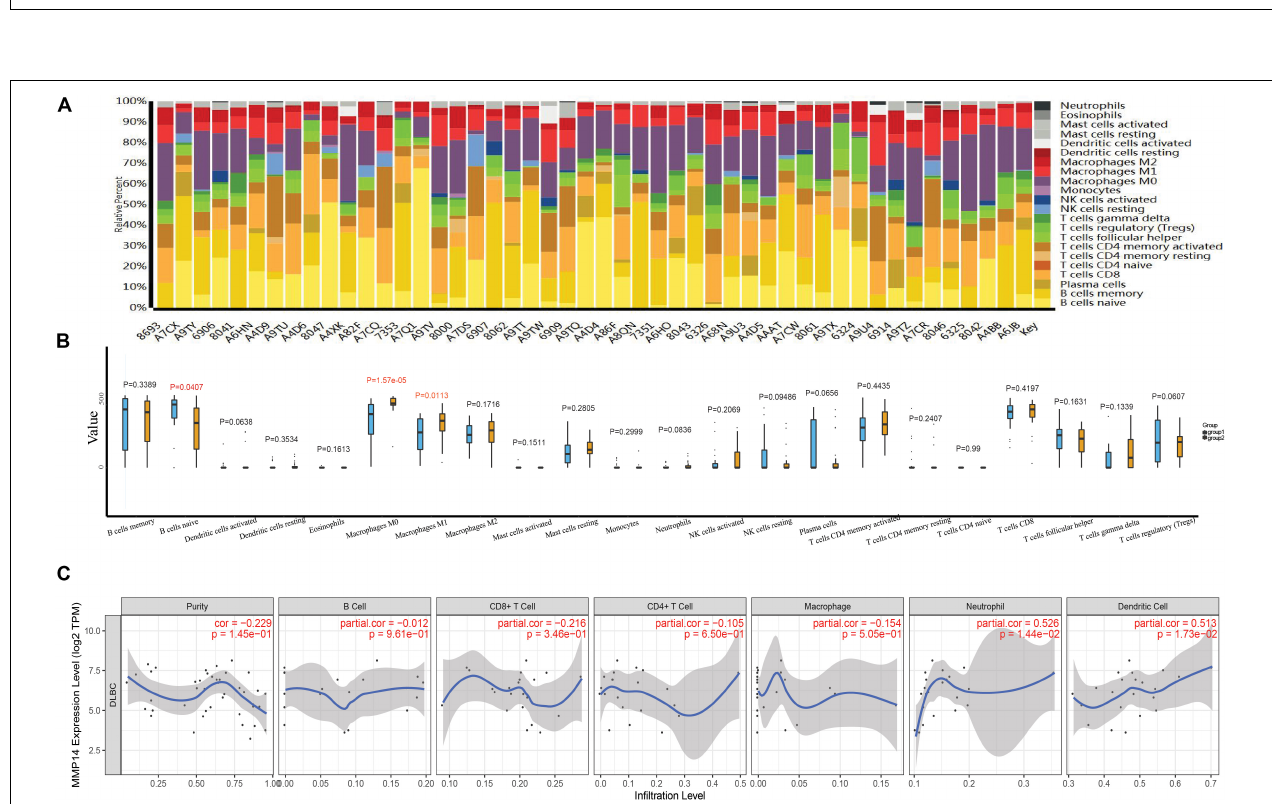
FIGURE 4 | (A) Bar plots of the abundance ratio of 22 immune cell types in 48 The Cancer Genome Atlas (TCGA)-DLBCL samples. Each type is shown in a different color. (B) Boxplots showing the infiltration levels of 22 immune cell types in low- and high-MMP14 expression groups. Blue: low-MMP14 expression group; yellow: high-MMP14 expression group. (C) Correlation of MMP14 expression with immune infiltration levels in DLBCL samples, as assessed by Tumor Immune Estimation Resource (TIMER) analysis.